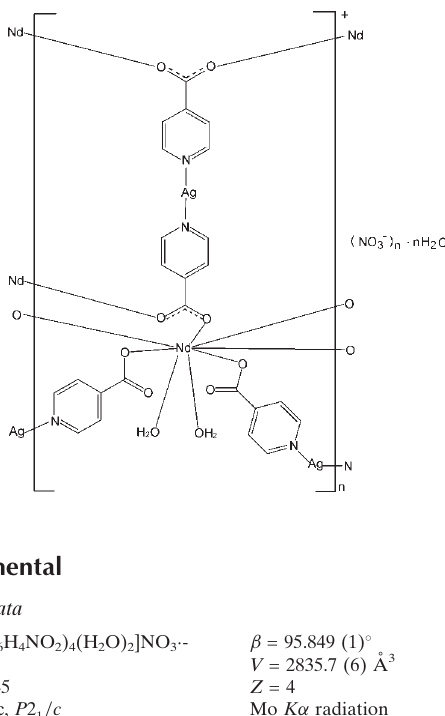
14629 measured reflections 5092 independent reflections